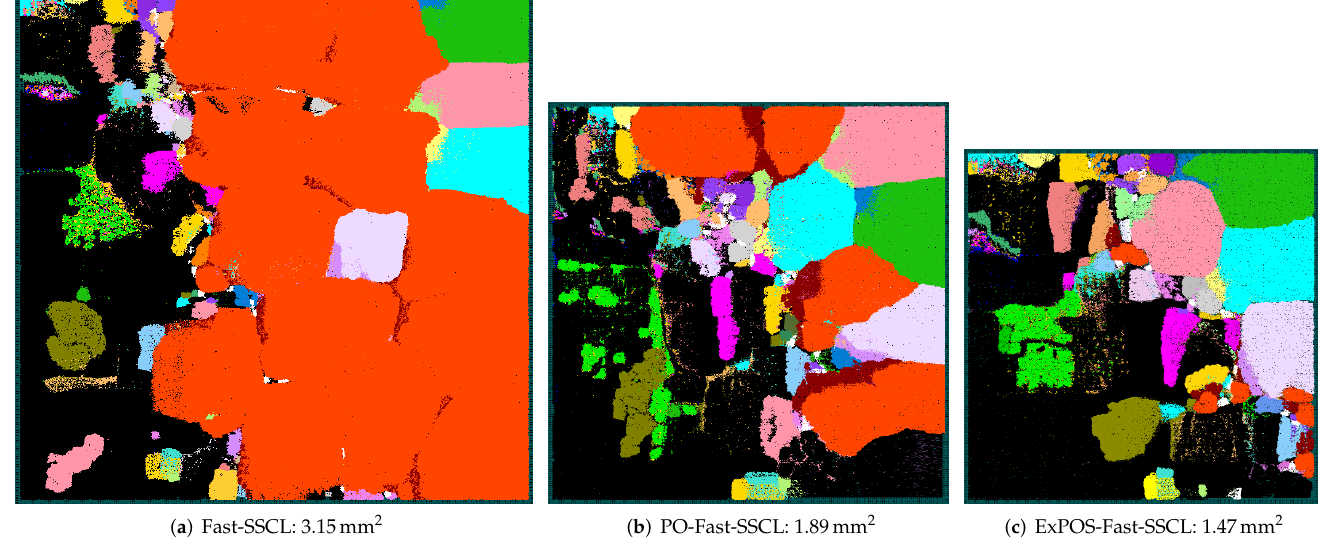
Figure 12. Layouts of ( a ) Fast-SSCL decoder [12], ( b ) PO-Fast-SSCL decoder, and ( c ) ExPOS-Fast-SSCL ( 128,70 ) and C = 6; computational kernels are represented by decoder with L = 8 for Polar code P different colors, delay line memory is colored in black; Rate-1 nodes and their dedicated sorter units are highlighted in dark-red and orange-red, respectively; all layouts have the same